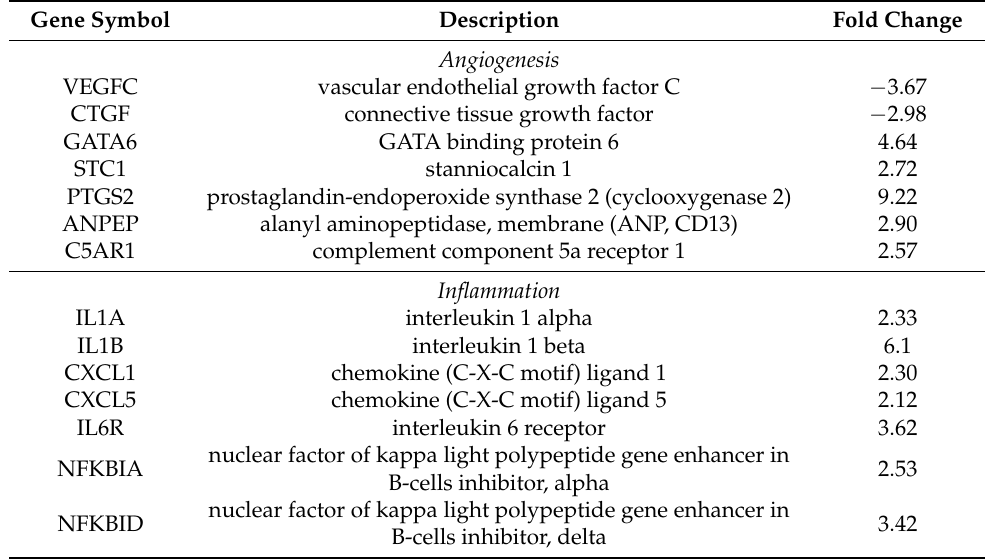
Table 2. Selected DEGs in untreated H460 COMMD1 KO vs. WT.